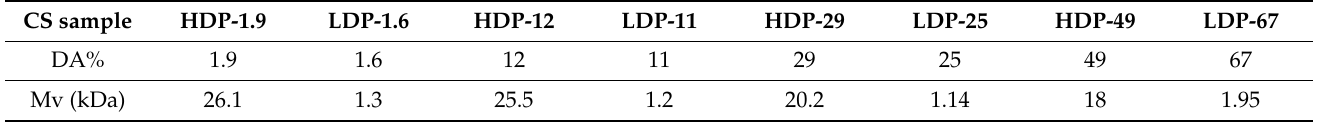
Table 2. Molar masses and DA% used in Santos-Carballal et al. studies